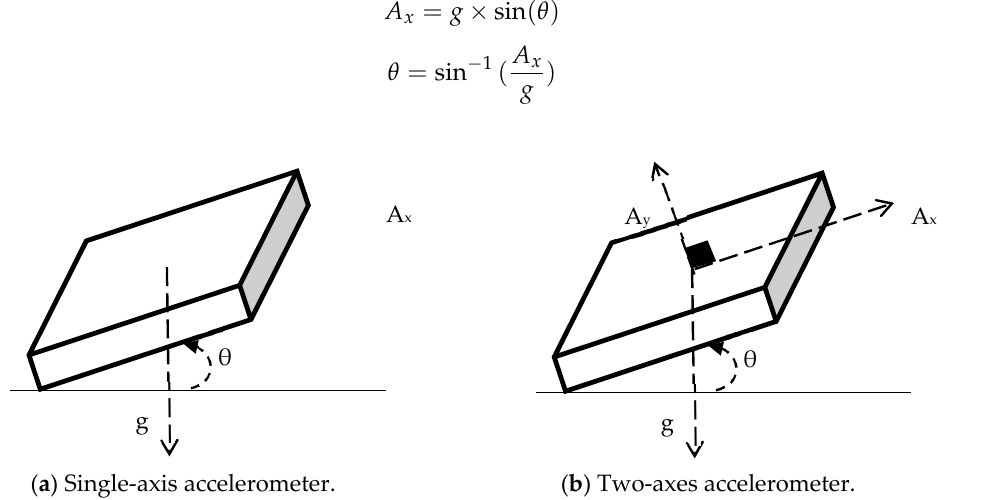
Figure 4. Sensing rotation using ( a ) a single-axis accelerometer, ( b ) a two-axes accelerometer.